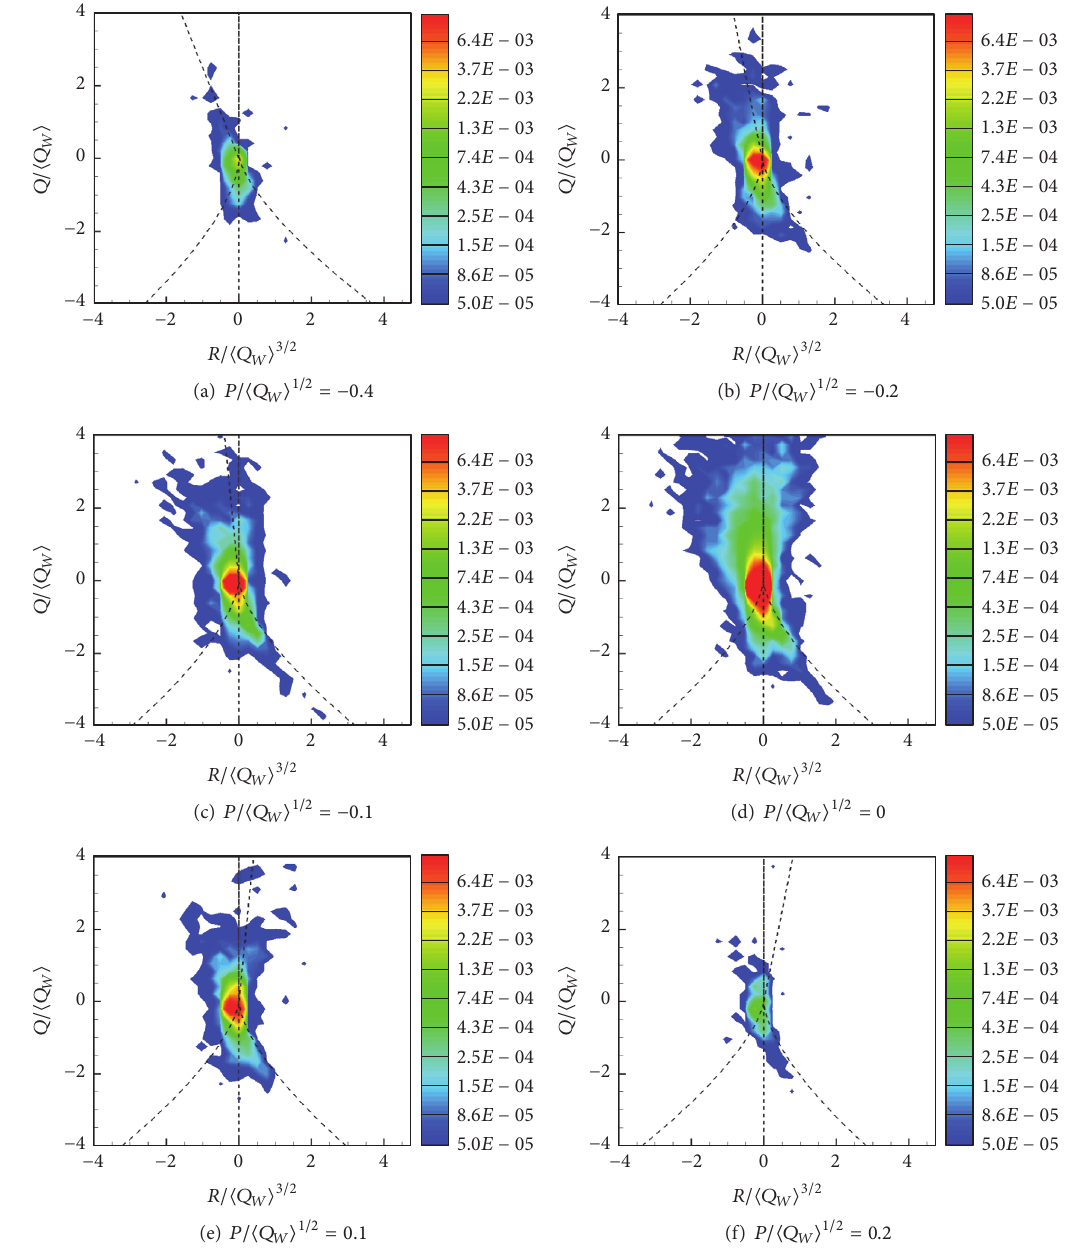
Figure 6: Joint p.d.f. of 𝑄 - 𝑅 invariants in the flame zone at 𝑡 = 189 𝜇